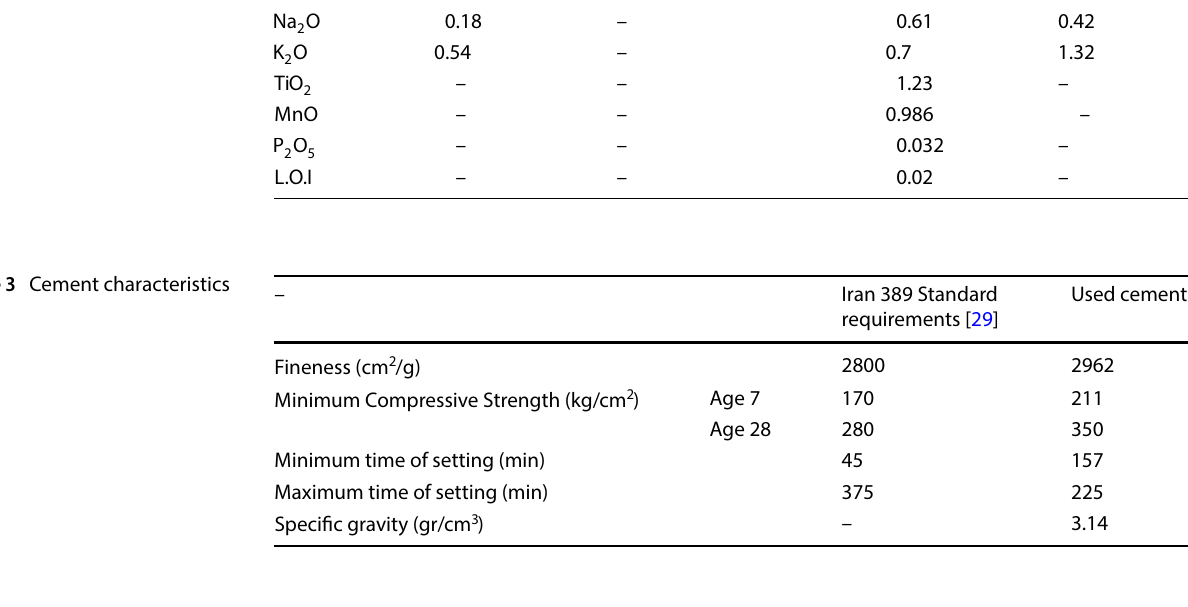
Table 4 Physical properties of silica fume and GGBFS